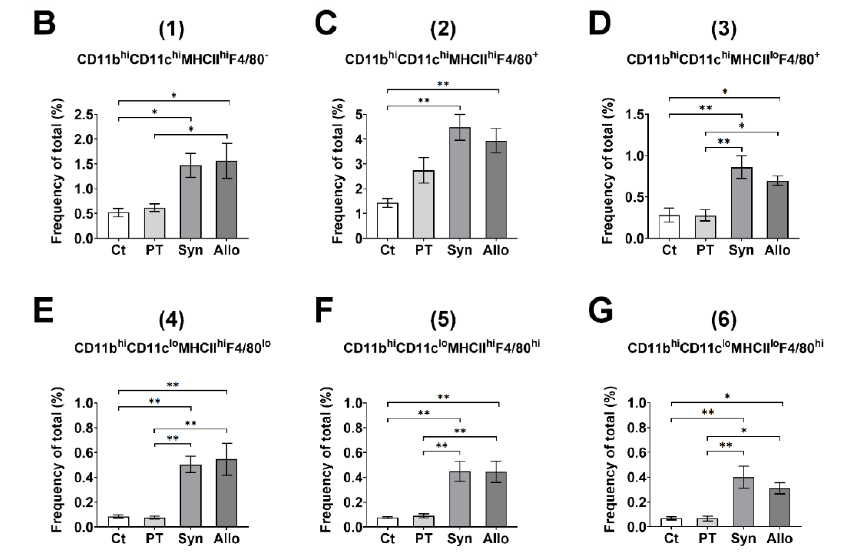
Figure 5. Intergroup difference in APCs with and without F4/80 expression in the ocular surface. ( A ) Representative photographs of the gating strategies to identify subpopulations of the CD11b hi CD11clo and CD11b hi CD11c hi APCs according to the surface expression of MHCII and F4/80. ( B – G ) The frequencies (% of total) of the CD11b hi CD11c hi MHCII hi F4/80 ‐ , CD11b hi CD11c hi MHCII hi F4/80 + , CD11b hi CD11c hi MHCII lo F4/80 + , CD11b hi CD11cloMHCII hi F4/80 lo , CD11b hi CD11c lo MHCII hi F4/80 hi , and CD11b hi CD11c lo MHCII lo F4/80 hi subsets were significantly higher regardless of the expression of MHCII and F4/80 in the Syn and Allo groups compared with the control and PT groups. n = 5 for each group; ANOVA followed by Bonferroni’s post hoc anal ‐ yses. * p < 0.05 and ** p < 0.01. Values are expressed as a mean ± standard error measurement. Ct indicates the control group; PT, the partial trephination group; Syn, the syngeneic corneal trans ‐ plantation group; and Allo, the allogeneic corneal transplantation group. Abbreviations: APC, anti ‐ gen ‐ presenting cell.